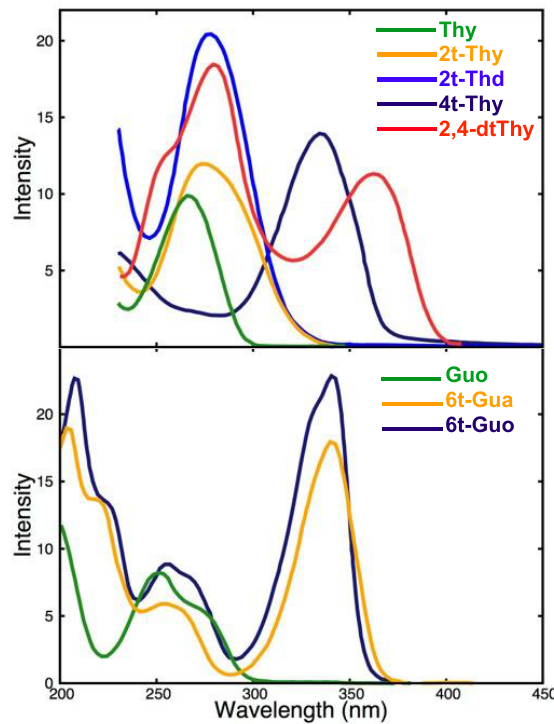
Figure 5. Experimental absorption spectra recorded in PBS, pH = 7.4 for Thy, Guo and their thioderivatives. The data for Thy and it derivatives ( Top ) was taken from Ref. [64]. The data for Guo and 6t-Guo ( Bottom ) was taken from Ref. [73] and the spectrum for 6t-Gua was extracted from Ref. [52].